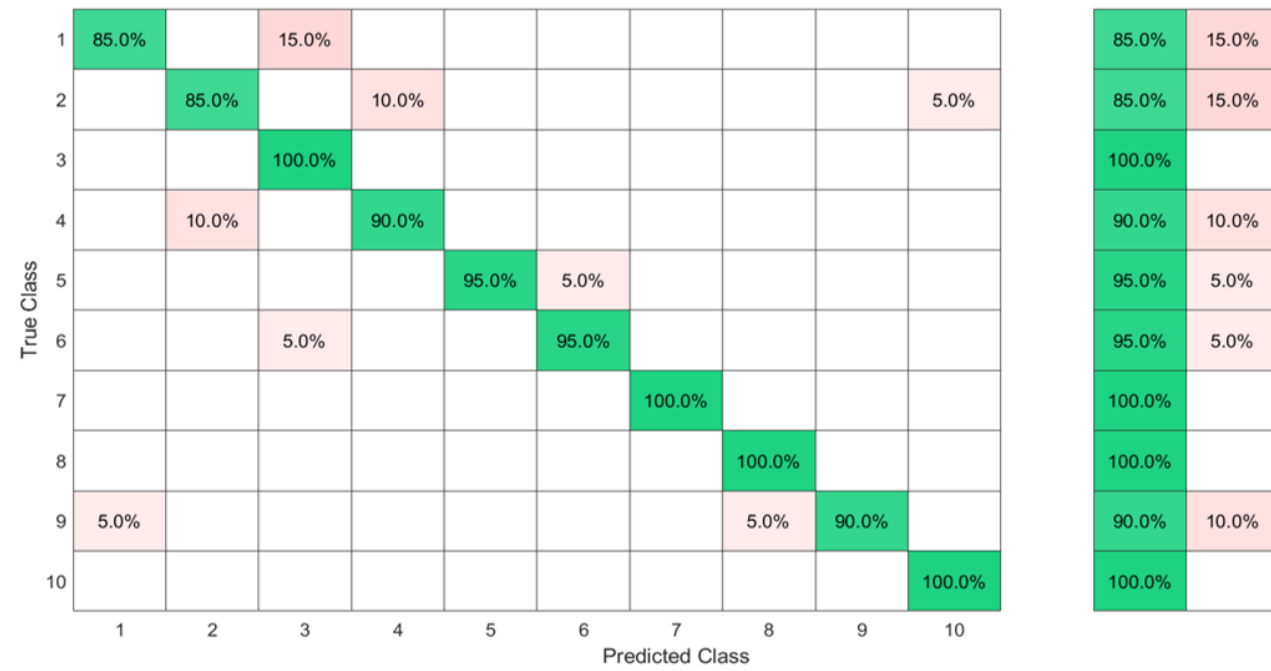
Figure 10. Ten ASL letters, A–J, detected with FMG and classified by the